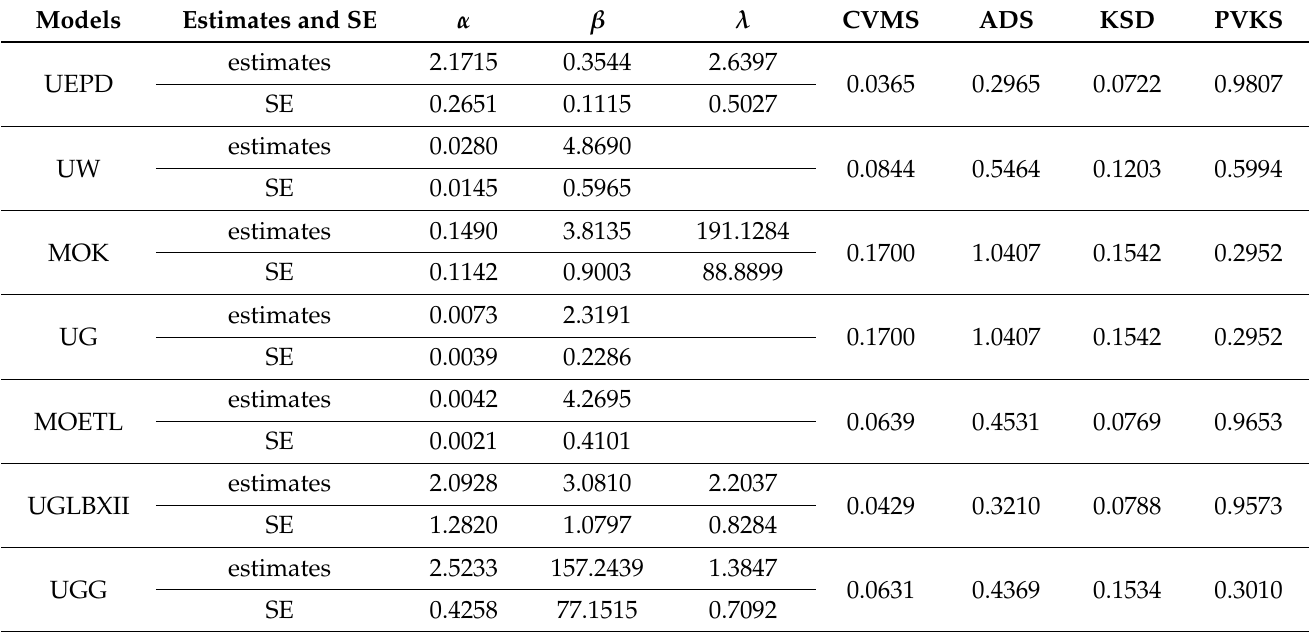
Table 14. M L E and SE with different measures of goodness of fit for the recovery rate of COVID-19 data in France.